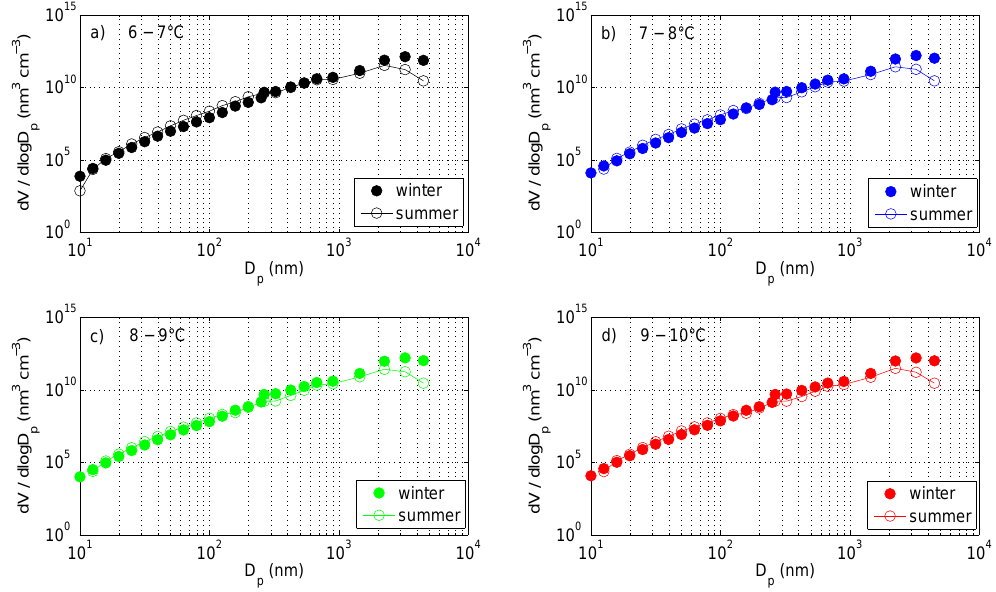
Fig. 8. Comparison of particle volume size distributions resulting from water sampled close to the fjord mouth during summertime and wintertime, for the same water temperature ranges of (a) 6–7 ◦ C, (b) 7–8 ◦ C, (c) 8–9 ◦ C and (d) 9–10 ◦ C. For clarity only every second data point is